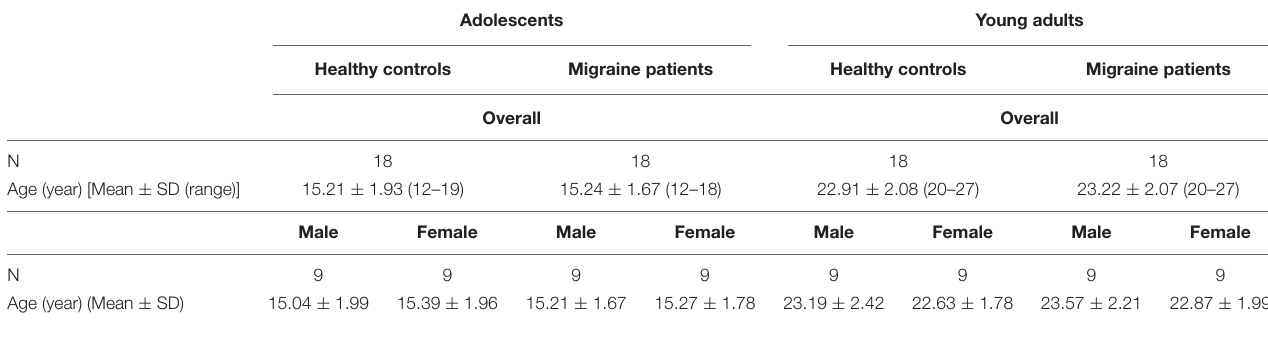
TABLE 1 | Demographic characteristics of migraine and healthy controls